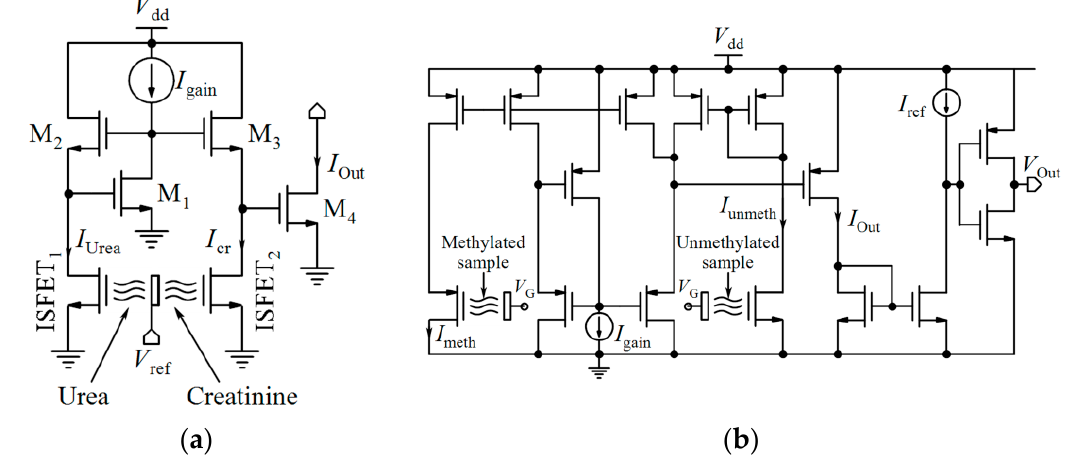
Figure 27. Ratiometric measurement: ( a ) ISFET based translinear divider; ( b ) a translinear circuit proposed by Kalofonou et al.